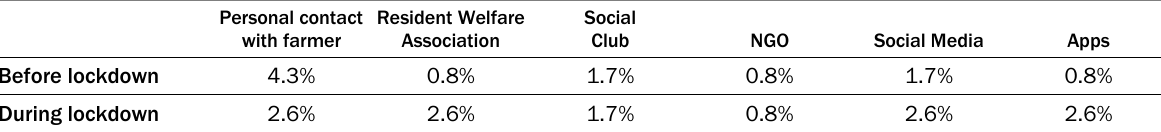
Table 3. Mode of Contact for Direct Purchase from Farmers Before and During Lockdown ( N